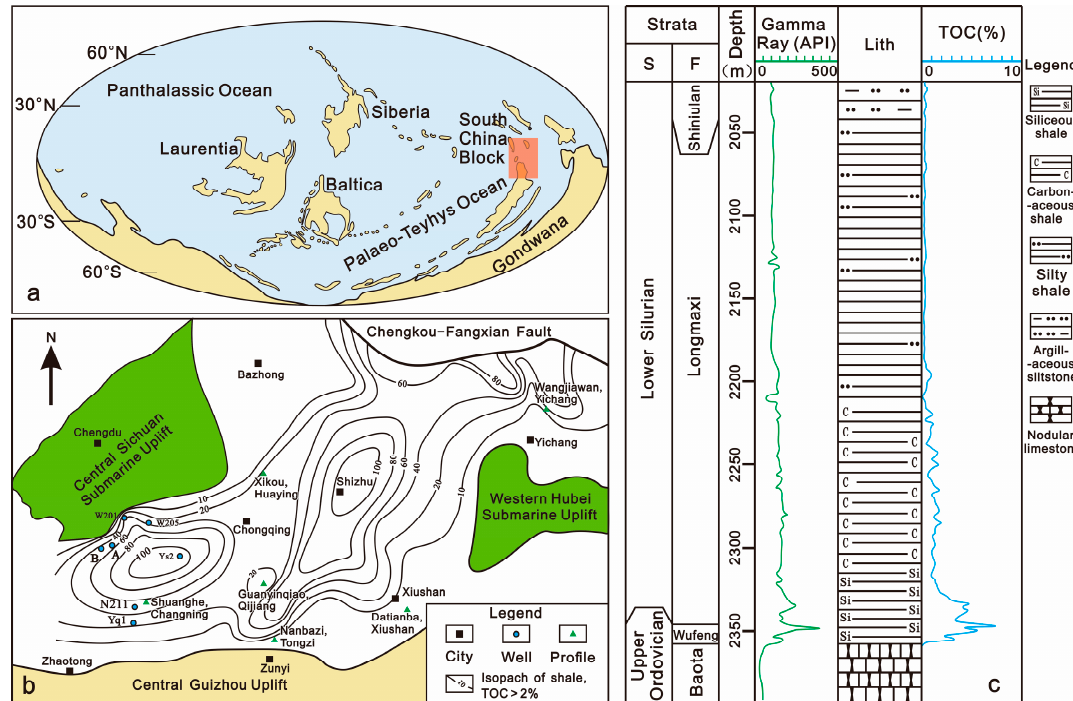
Figure 1. ( a ) Location of the South China Block (based on the results of Zhou et al. [12]); ( b ) distribution of the Upper Yangtze organic-rich shales (based on the results of Wang et al. [1]); and ( c ) stratigraphic profile of the Wufeng and Longmaxi Formations of Well N211.